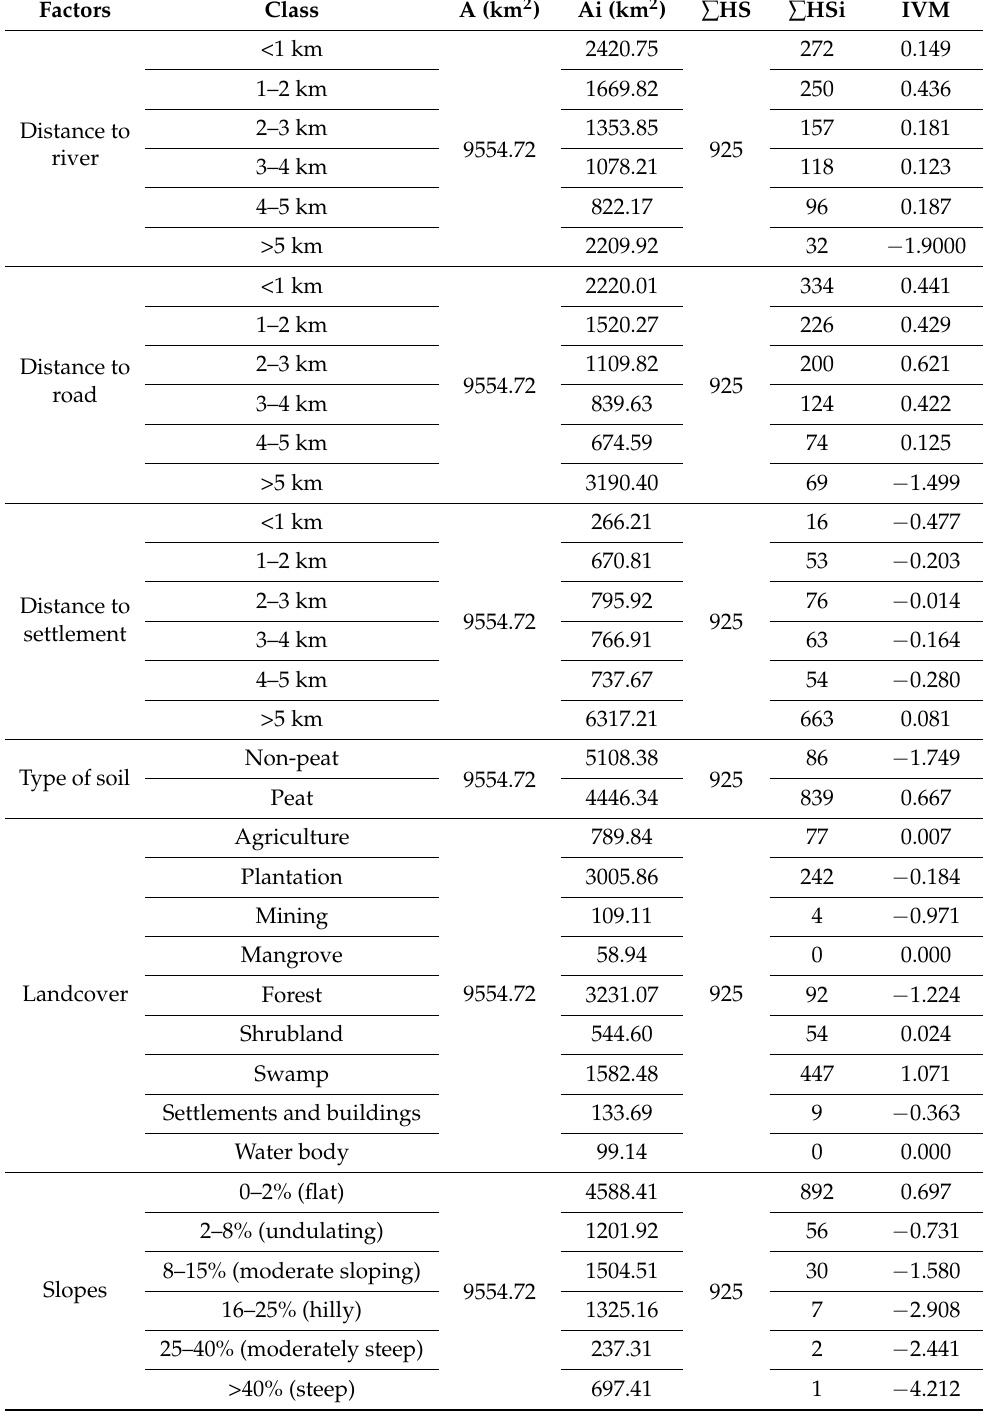
Table 3. Information value method